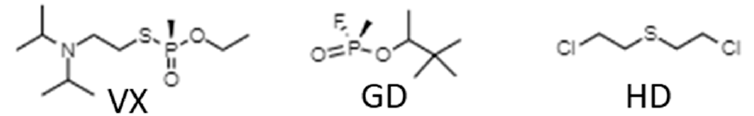
Figure 1. Molecular structures of the most cited CWAs in literature, VX, GD e HD. Nerve agents (or neurotoxic agents): target the central nervous system, reacting with AchE enzyme, resulting in convulsions, respiratory collapse and even death [19]. Between these agents, the ones stand out are tabun, sarin, soman and VX [9]. They represent one of the most dangerous type of CWAs since they provoke fast effects and can enter the victim’s body by several routes [21]. For example, their skin permeability rates are of approximately 0.1 cm/min [18]. In the specific cases of the chemically pure forms of G-agents, like soman and sarin, they have a water-like appearance and are soluble in water and organic solvents. They are also volatile which makes the respiratory tract the most probable entryway in the victim’s organism [21].